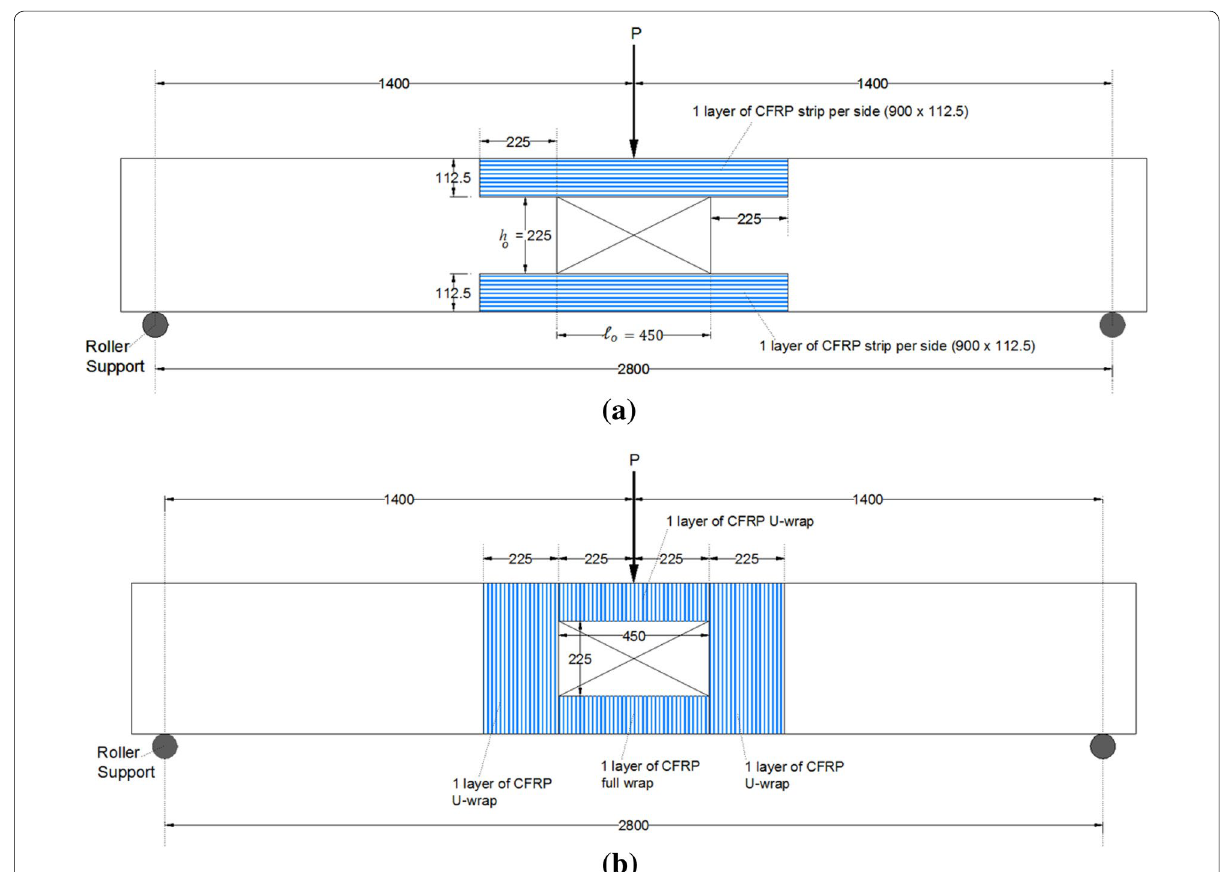
Fig. 4 Details of strengthening scheme‑1 for specimen BS1‑O1‑CPL (Note: all dimensions are in mm): a 1st CFRP layer and b 2nd CFRP